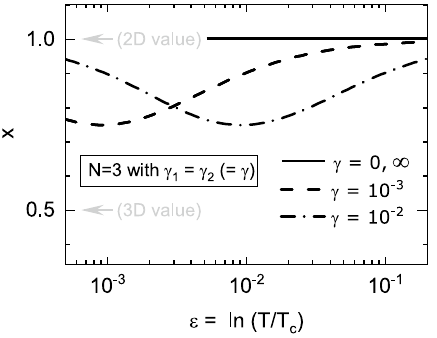
Fig. 8 Critical exponent x of c fl (and of − 𝜒 fl ∕ T and 𝜎 flAL ) for three-layer superconductors with a single Josephson coupling, 𝛾 = 𝛾 1 = 𝛾 2 , as a function of 𝜀 and for different 𝛾 . The figure illus- trates deviations from the 2D value ( x = 1 ) when 𝜀 and 𝛾 take com- parable values, which may be further understood when contrasted with the N e evolution in Fig. 9